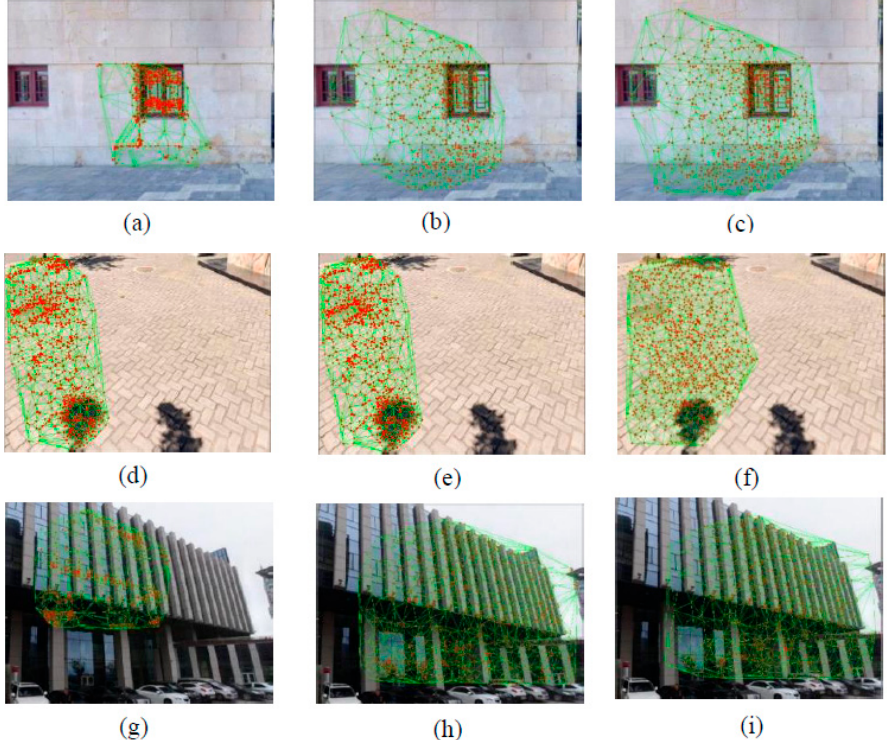
Figure 10. Matching results of the three methods tested on satellite stereo images WX1–3. ( a , d , g ) tested on ASIFT. ( b , e , h ) tested on Brown-AffNet. ( c , f , i ) tested on SJRS-AffNet.